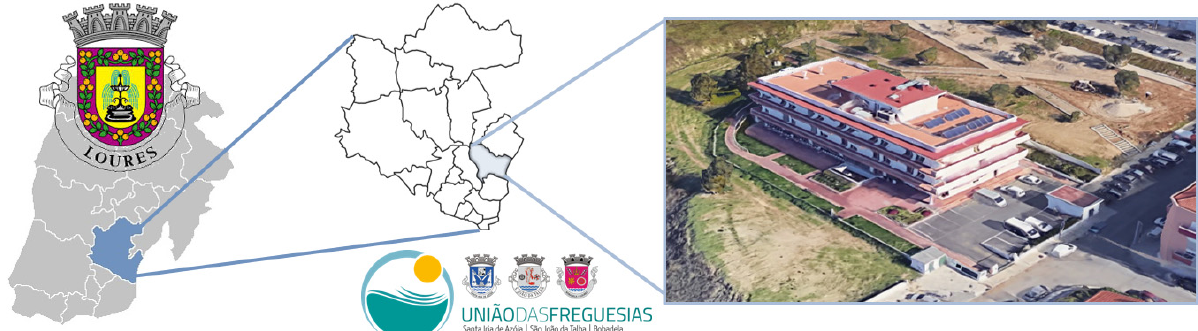
Figure 1. Geographical location of the residential structure for the elderly “ Cooperativa de Solidariedade Social Os Amigos de Sempre ” .